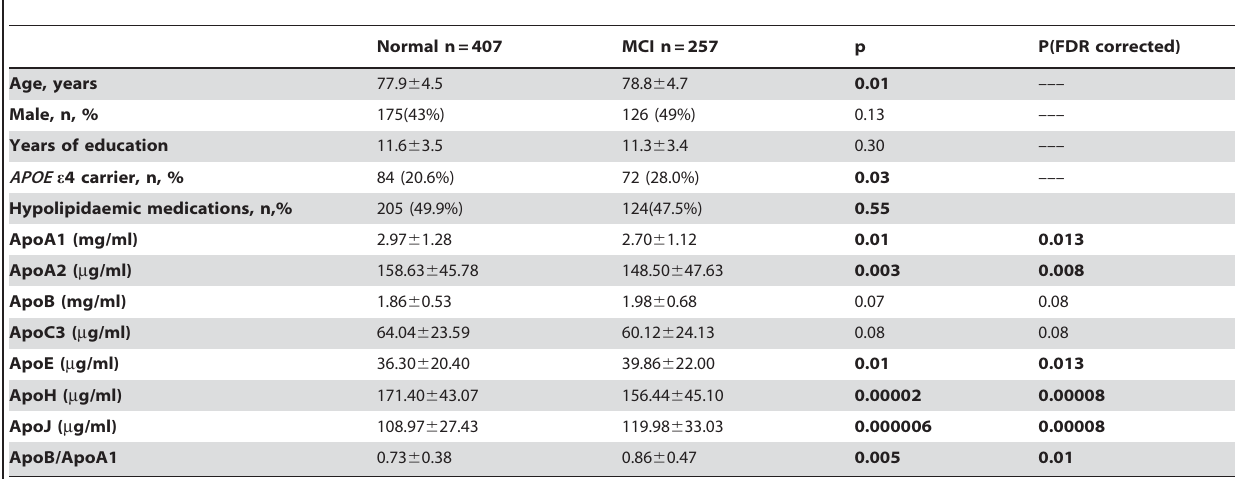
Table 1. Participant Wave 1 demographic information and apolipoprotein